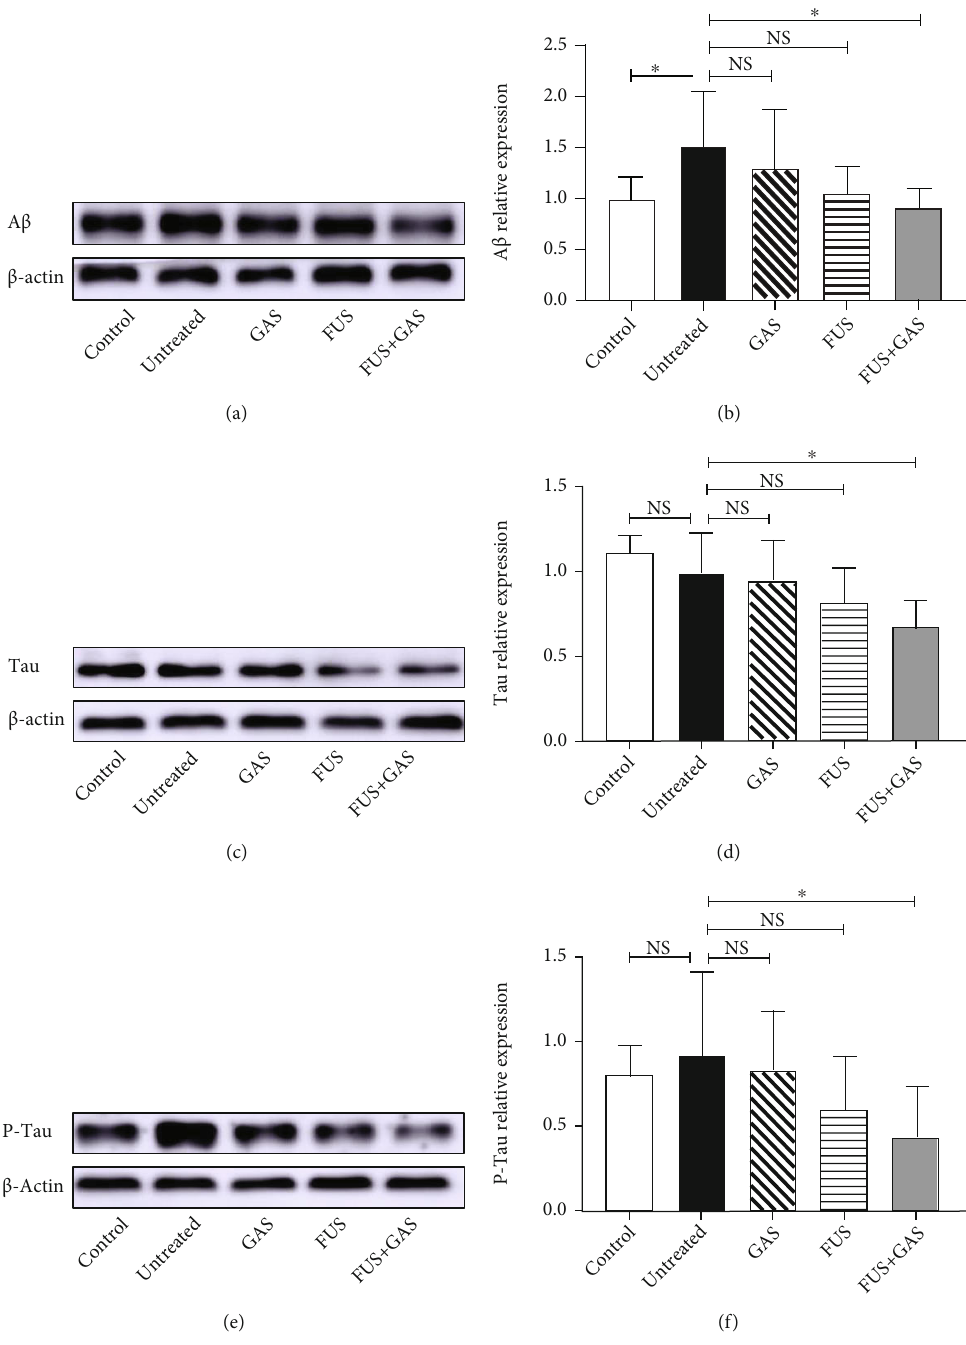
Figure 8: The e ff ects of combined treatment (FUS+GAS) on the level of A β (a, b), tau (c, d), and P-tau (e, f) in the left hippocampus. The content of A β was increased markedly in the untreated group. Combined treatment reduced the content of A β , tau, and P-tau in the targeted hippocampus. Each symbol represents the mean ± SD ; ∗ P < 0 : 05 against untreated mice. One-way ANOVA; n = 5 per